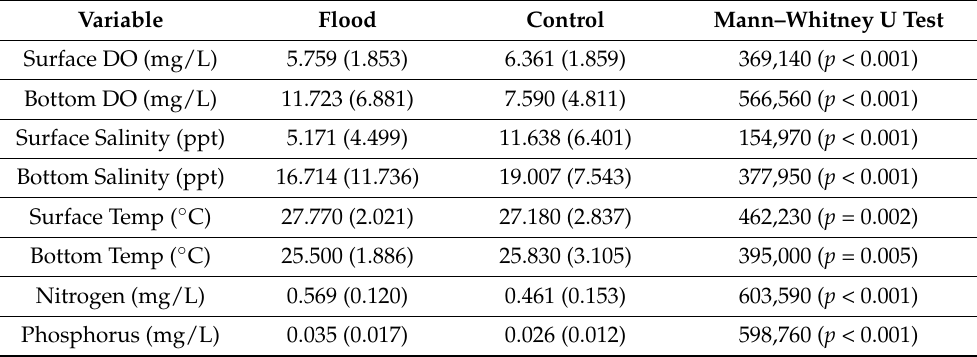
Table 2. Average, standard deviation (in parentheses), and Mann–Whitney test statistic with p -value (in parentheses) for environmental variables across flood-impacted sessions and control